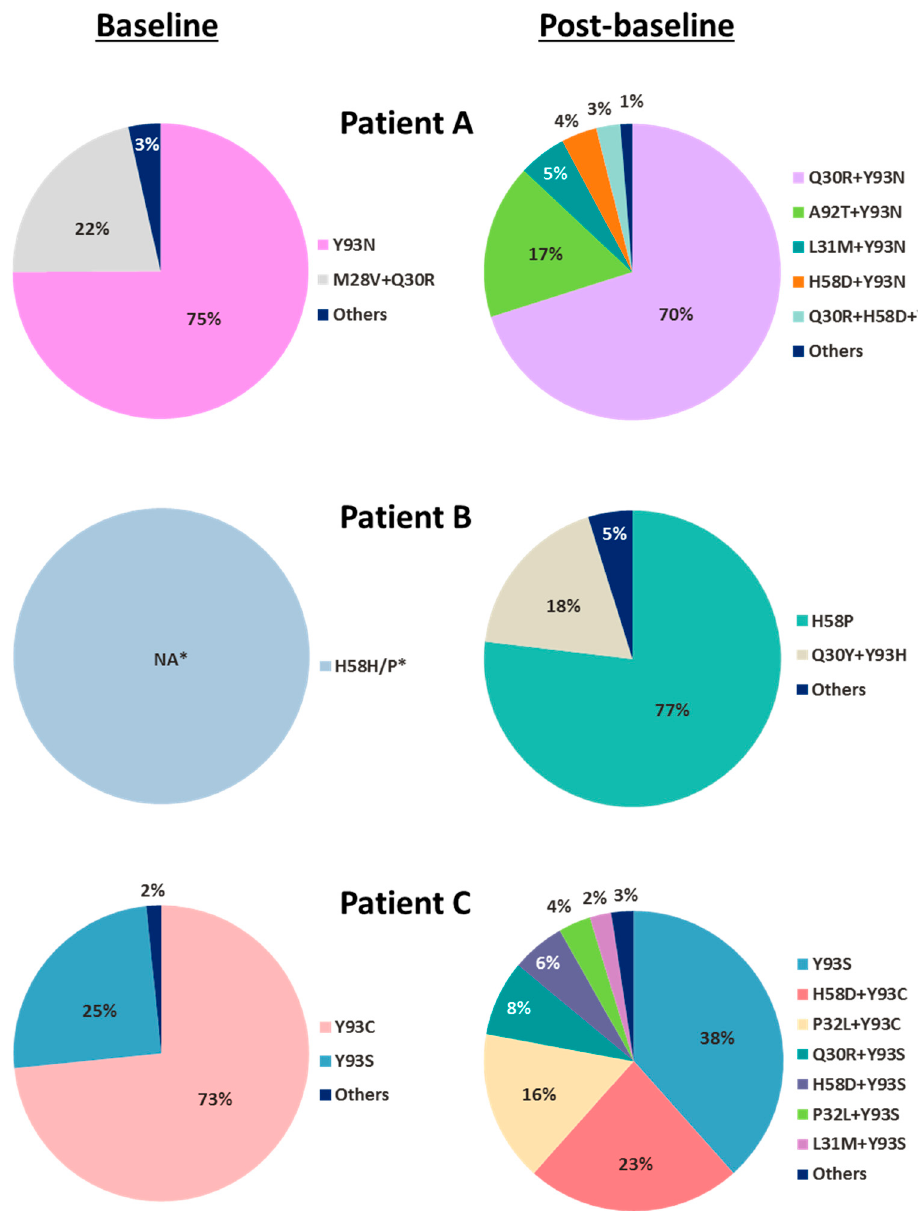
Figure 1. Baseline and post-baseline NS5A substitutions from 3 patients with multiple treatment- emergent NS5A substitutions during pibrentasvir monotherapy. For the 3 patients (Patients A–C) who were identified by population sequencing to have multiple treatment-emergent NS5A substitutions during pibrentasvir monotherapy, their baseline and post-baseline samples were